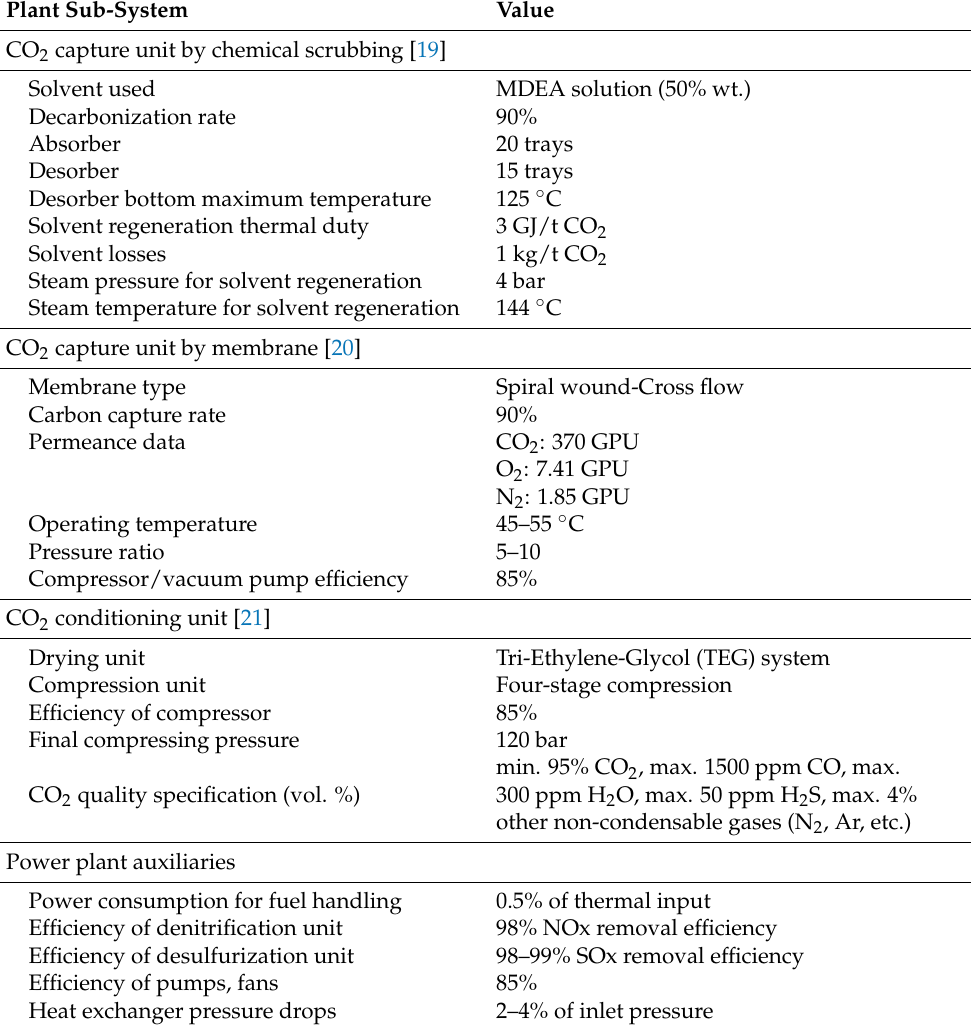
Table 1. Cont. Plant